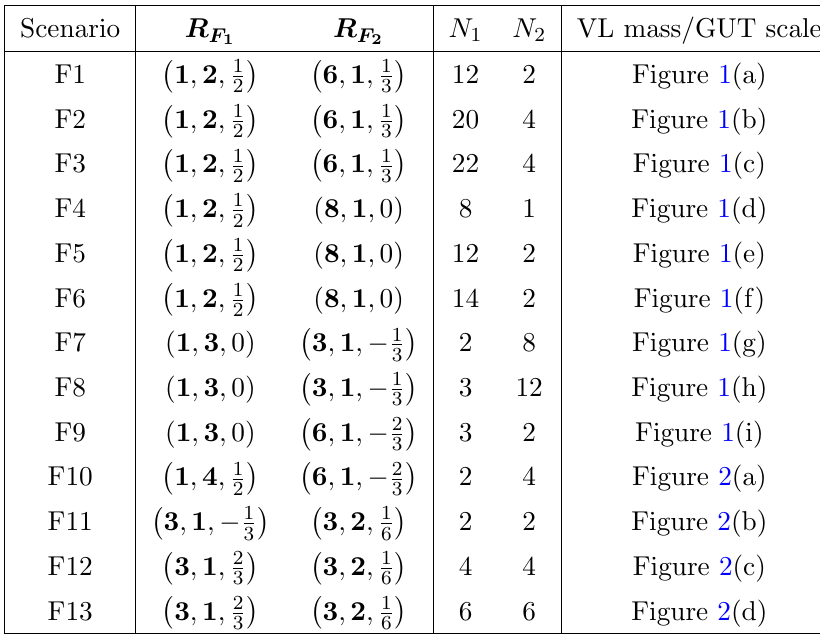
Table 3. Scenarios with 2 representations of VL fermions that allow for the PGU ( (cid:15) GUT (cid:20) 1%) and the associated uni(cid:12)cation scale lies in the range 10 15 (cid:0) 10 18 GeV. The VL masses vary